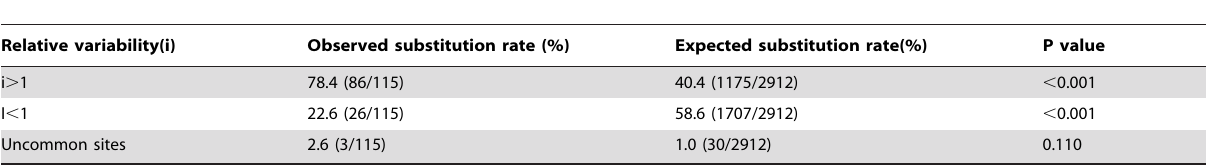
Table 2. Observed and expected variability in 23S rRNA genes in T. tengcongensis.